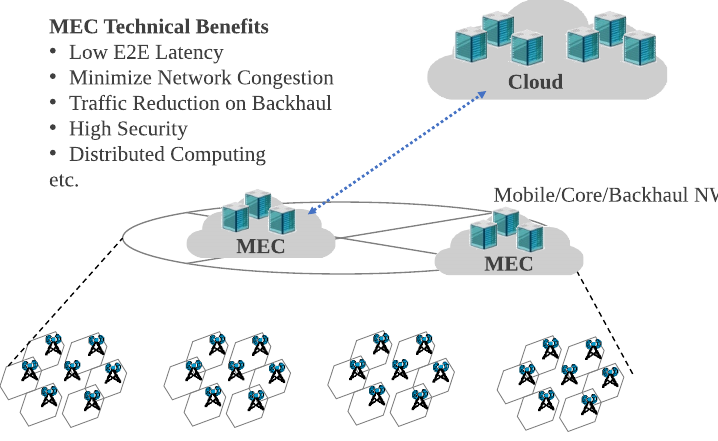
Figure 1. Benefits of MEC compared to cloud